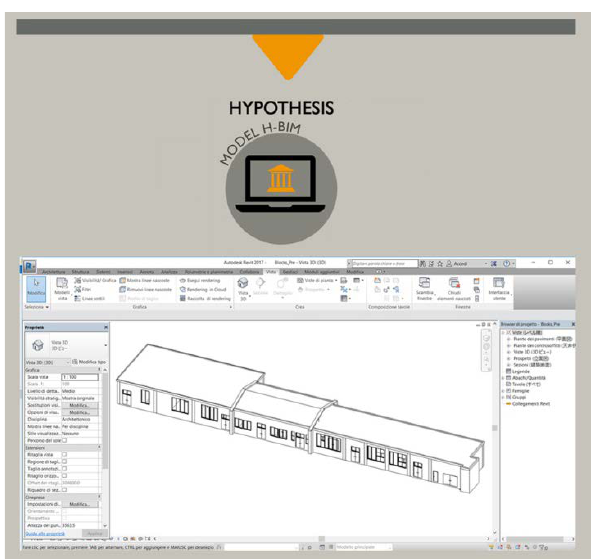
Figure 11: From exiting drawings to hypothesized Revit model.